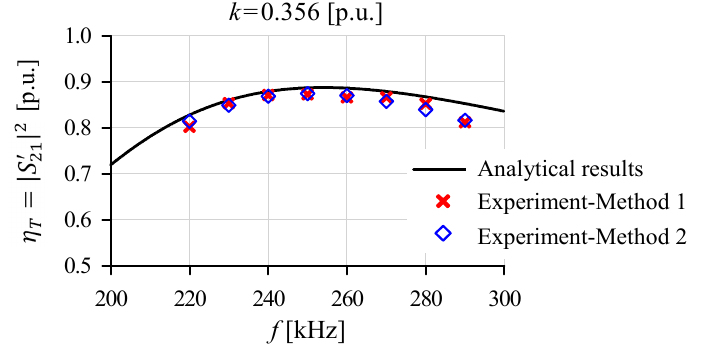
Figure 11. Power transfer efficiency of the matched asymmetric wireless power transmission system versus operating frequency ( f ).